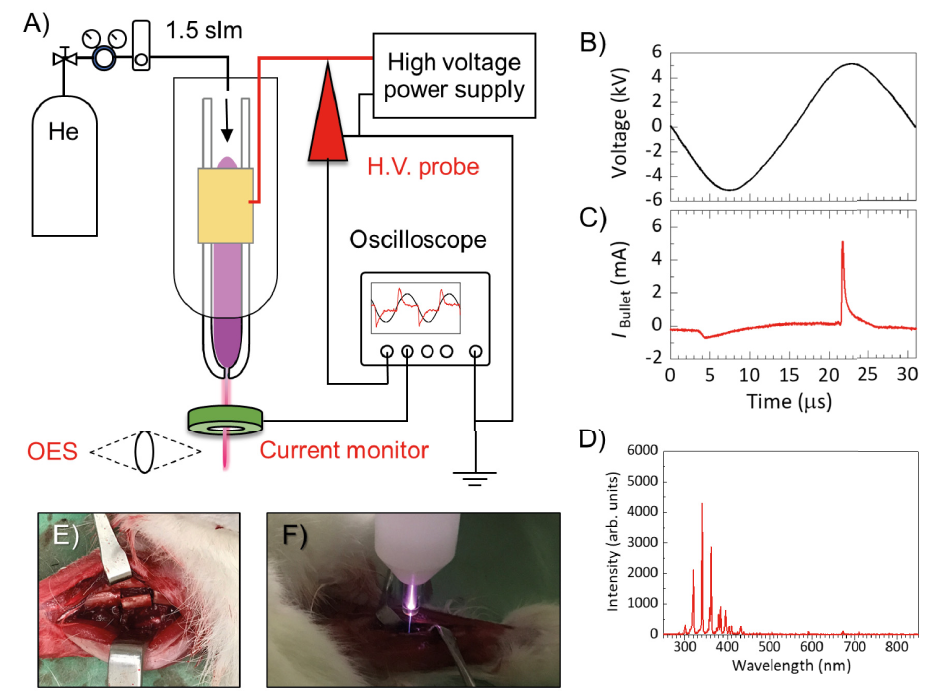
Fig 1. Experimental set-up of helium microplasma jet to measure voltage and current measurements, and optical emission spectroscopy for understanding fundamental plasma properties. 1B shows a sinusoidal high voltage waveform and typical bullet current. 1D shows an optical emission spectrum of plasma jet mainly N 2 2nd positive systems. 1E shows a large bone defect model of ulna on the foreleg of New Zealand White Rabbits and 1F shows a plasma treatment on the large bone